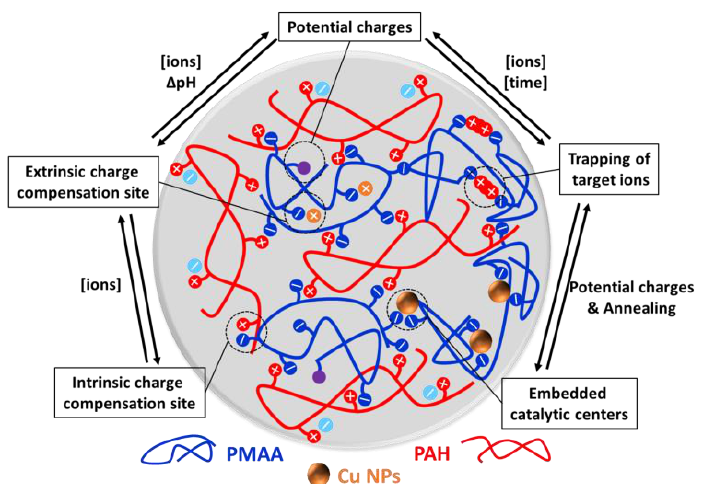
Figure 5. Pharmaceutical requirements. Schematic representation of the different possible mechanisms induced by pH, ion concentration, and ion valency changes in a PAH/PMAA saloplastic. Reproduced with permission from the original article [8]. Table 6. Recently reported weak polyelectrolytes complexes processed into gels and emerging ap- plications.